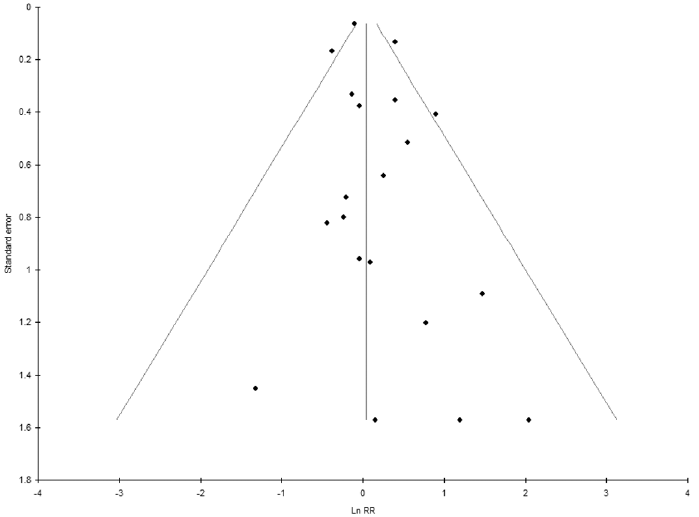
Fig 3. Funnel plot of clinical dataset results (test for publication bias). ln RR = natural logarithm Relative risk.